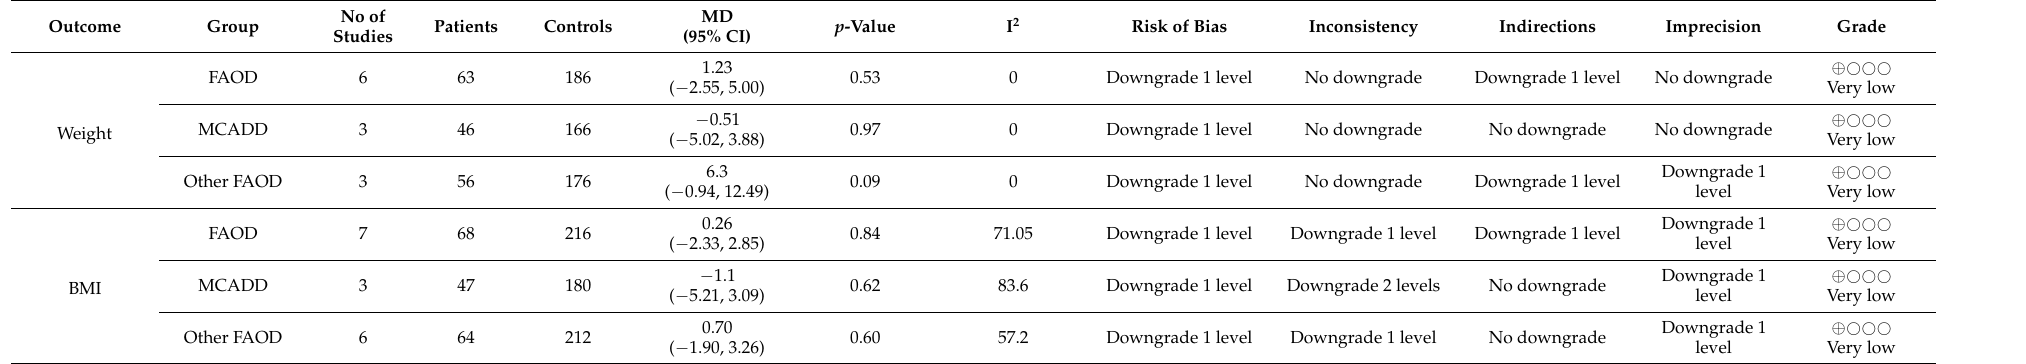
Table 4. Certainty of evidence evaluated using GRADE